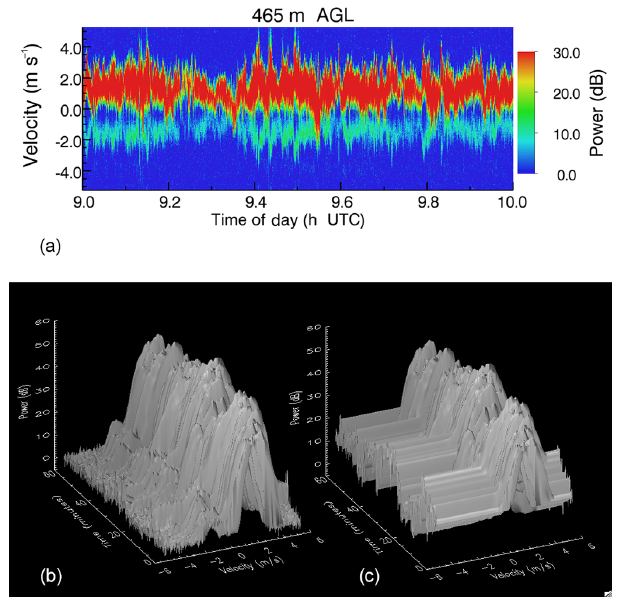
Figure 2. Doppler spectra example from 9 October 2004 09:00– 10:00UTC for the 465m height range gate (a) . The data are also plotted in 3-D (b) and with the raised noise floor to correct for spec- tral image artifacts in (c)